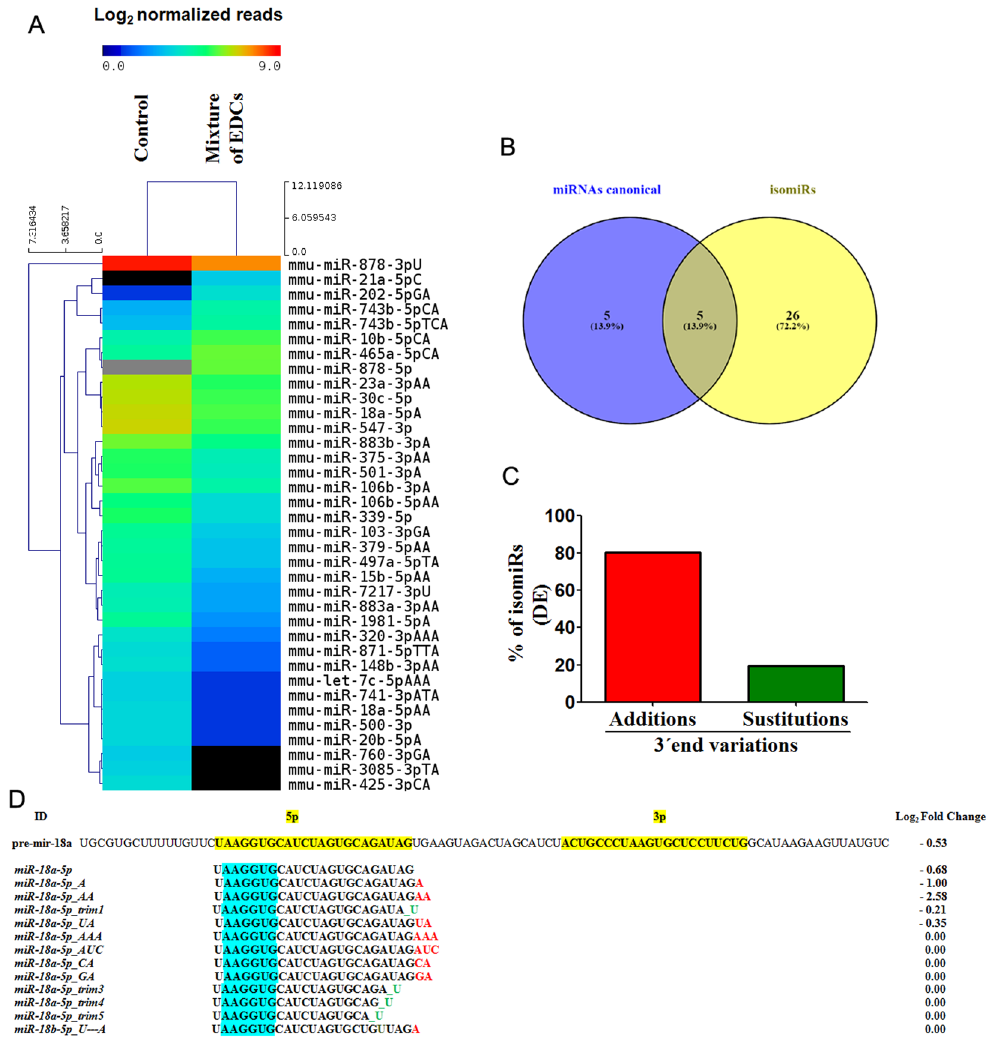
Figure 6. Analysis of differentially expressed isomiRs. ( A ) Hierarchical cluster analysis of differentially expressed isomiRs. Expression levels correspond to log 2 normalised read counts using DeSeq tool of the R/ Bioconductor software package, in testes of control mice and mice exposed to the mixture of EDCs. ( B ) Venn diagram showing the number of differentially expressed isomiRs in relation to canonical miRNAs. ( C ) Modifications of differentially expressed isomiRs variants, affecting the 3 ′ end. No variants were detected at the 5 ′ end. ( D ) Sequences and values of expression levels compared to control condition for normalised reads of pre-mir-18a-5p , canonical miR-18a-5p and miR-18a-5p -derived isomiRs. Fold change (log 2 ). Data normalised using DeSeq tool of the R/Bioconductor software package, * p ≤